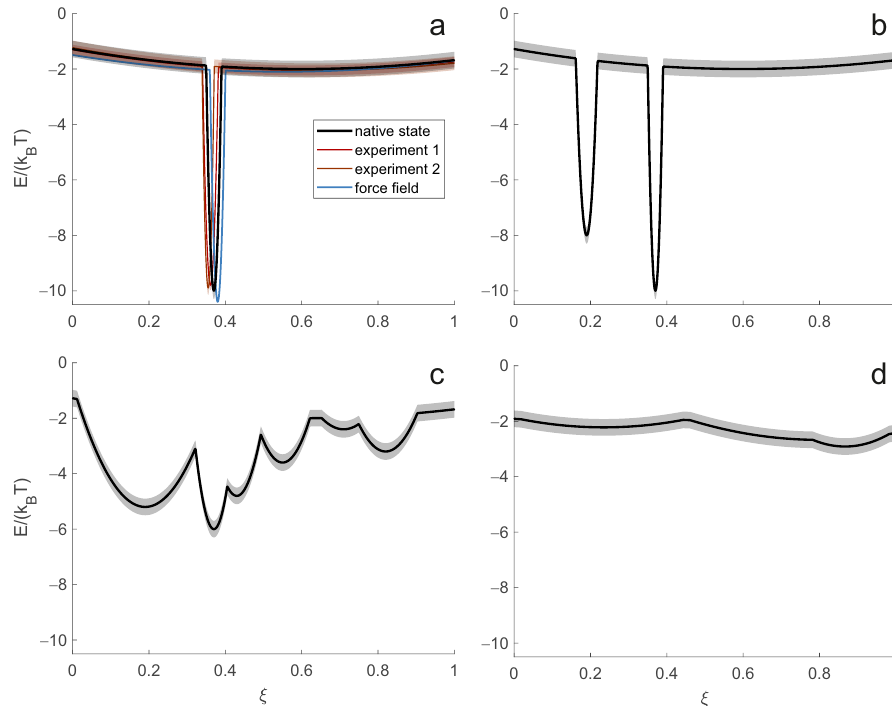
Figure 2. Classification of energy landscapes of biomolecular systems. Energy landscapes are associated with uncertainties (semitransparent bands), as explained in the text. ( a ) Anfinsen limit with a single minimum several times the thermal energy k B T lower than the rest of the hypersurface. Shown are the slightly different energy landscapes corresponding to the system in the living cell (black), two different experimental series 1 (red) and 2 (orange-red), and a molecular force field (blue). ( b ) System with two separate minima differing by only a small multiple of k B T . ( c ) Energy landscape, with ruggedness on the order of k B T . ( d ) Energy landscape that is nearly flat on the order of k B T